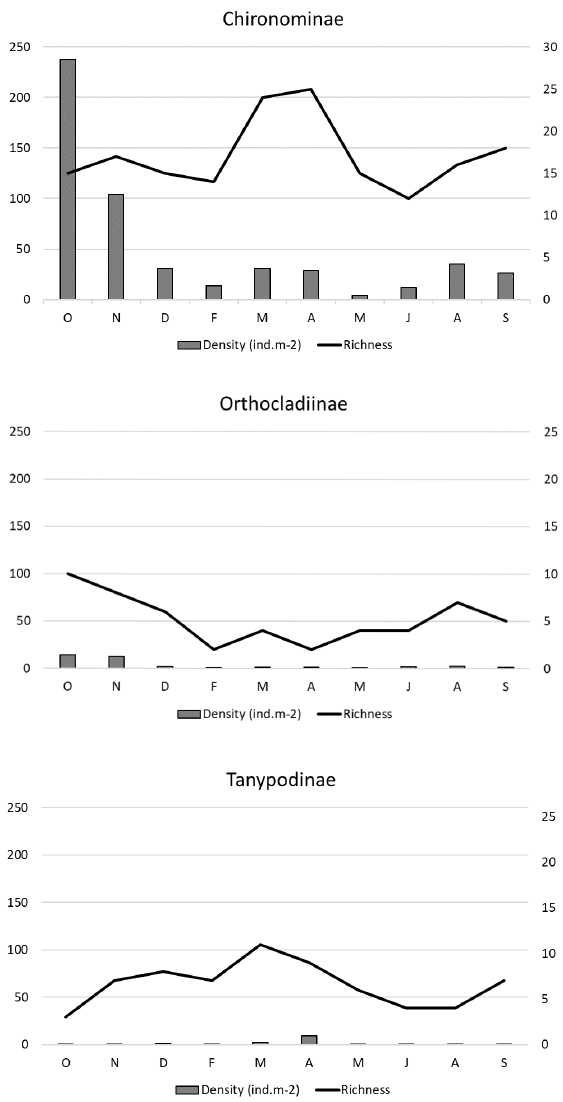
Figure 3. Monthly variation in the density and richness of the Chironomidae